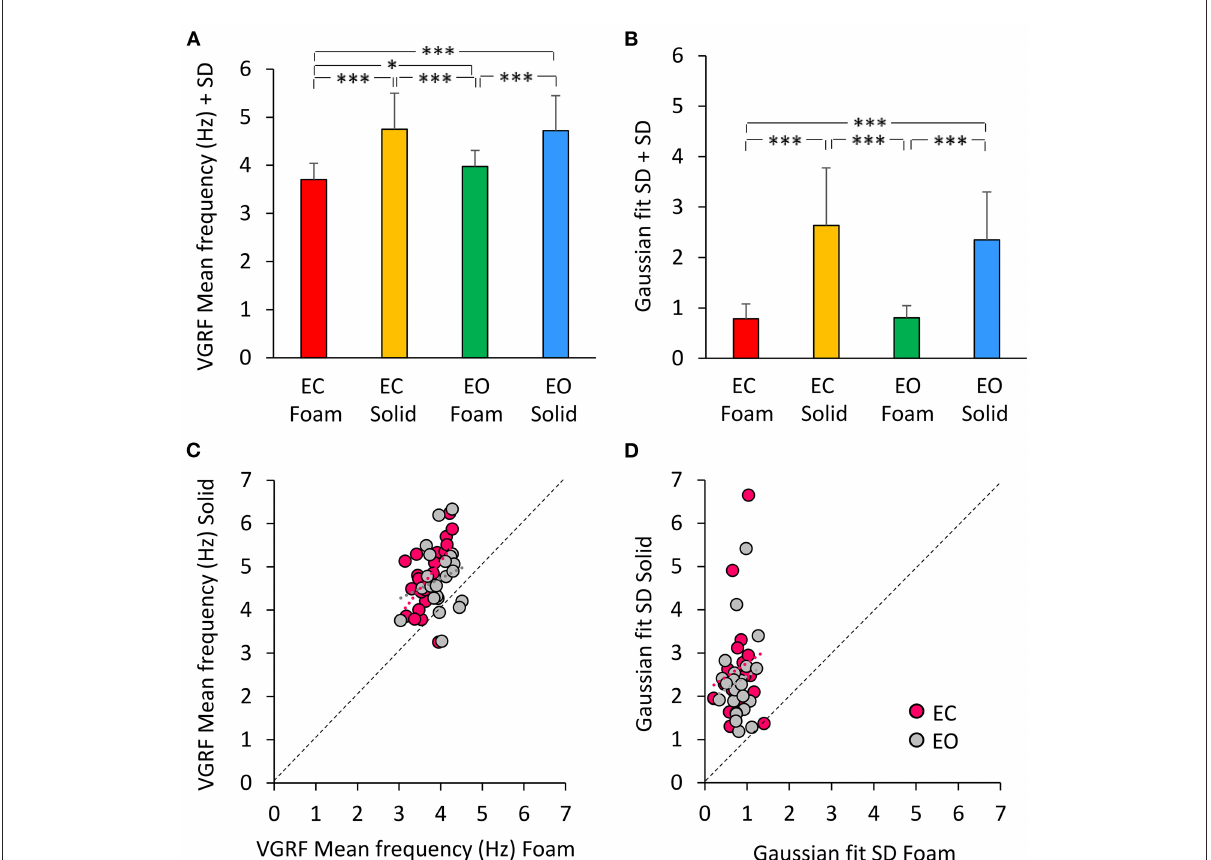
FIGURE4 The VGRF mean frequency and the SD of the Gaussian fit. The mean values of the VGRF Mean frequency (A) and of the SD of the Gaussian curve (B) calculated across subjects are reported for each visual and support condition. The relationship between the Solid and Foam support data for the Mean frequency values and SDs are shown in (C,D) . Pink dots are referred to EC, gray dots to EO condition. The black dotted lines are the identity lines. The Mean frequency and the SD were greater for Solid than Foam support. The dot distribution in the abscissa shows that regardless of the support condition, there was no difference between EC and EO in VGRF Mean frequency and SD. The equations of the lines fitting the Solid vs. Foam Mean frequency values were: EC, y = 1.26 x + 0.06 (R 2 = 0.32, p < 0.01); EO, y = 0.47 x + 2.84 (R 2 = 0.05, p = 0.33). The regression lines fitting the Solid vs. Foam SDs of the Gaussian fit were y = 0.65 x + 2.12 (R 2 = 0.03, p = 0.44) for EC, and y = 0.61 x + 1.86 (R 2 = 0.02, p = 0.48) for EO. Asterisks indicate significant differences (* p < 0.05; *** p <